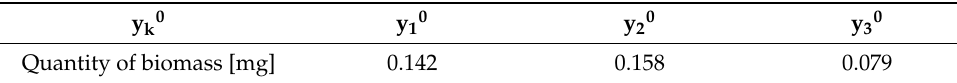
Table 2. Values in the central point of the